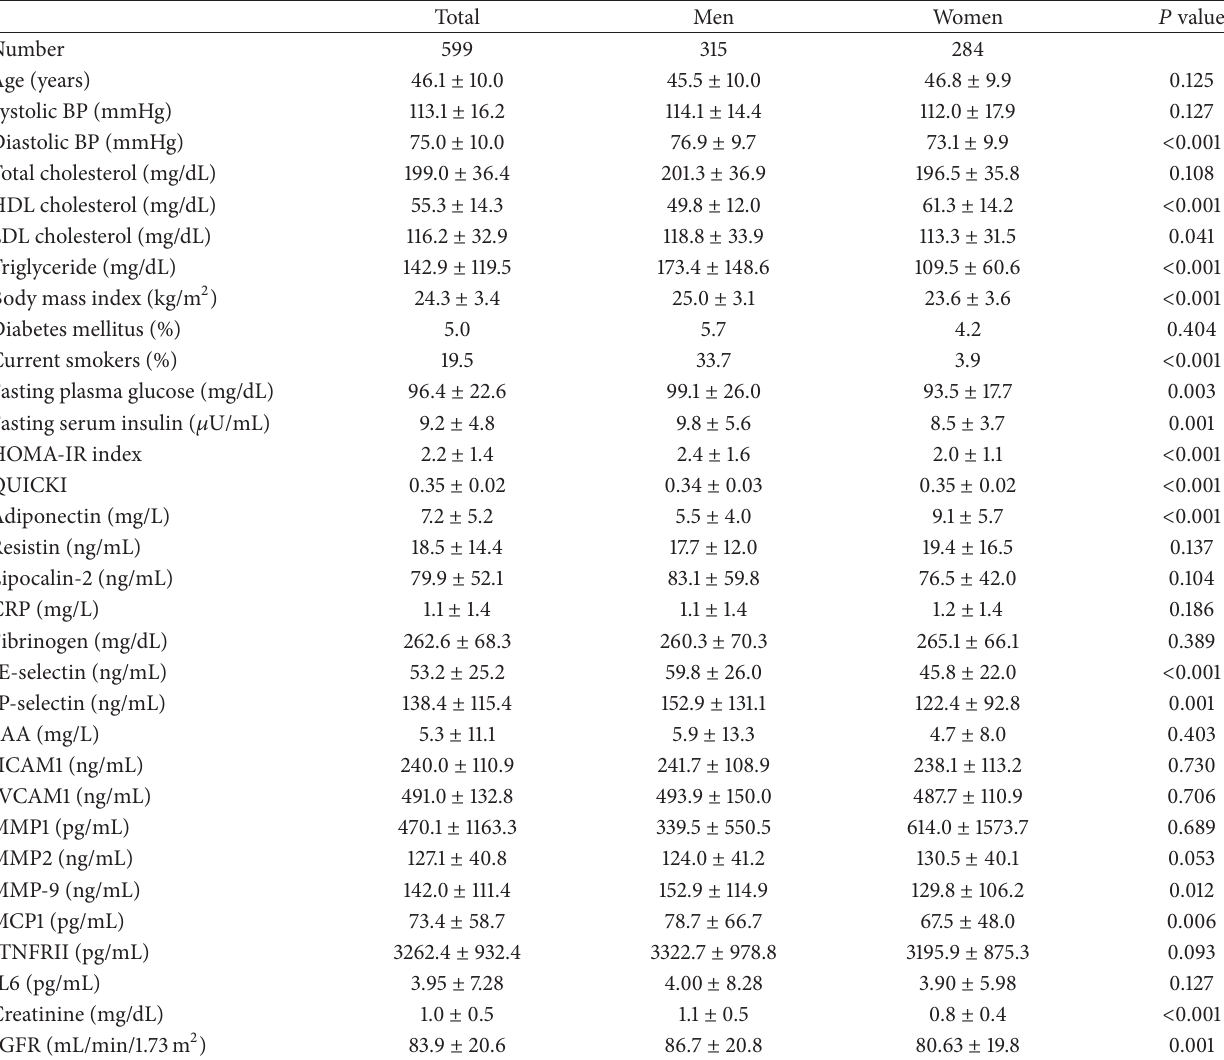
Table 1: Baseline characteristics of the studied